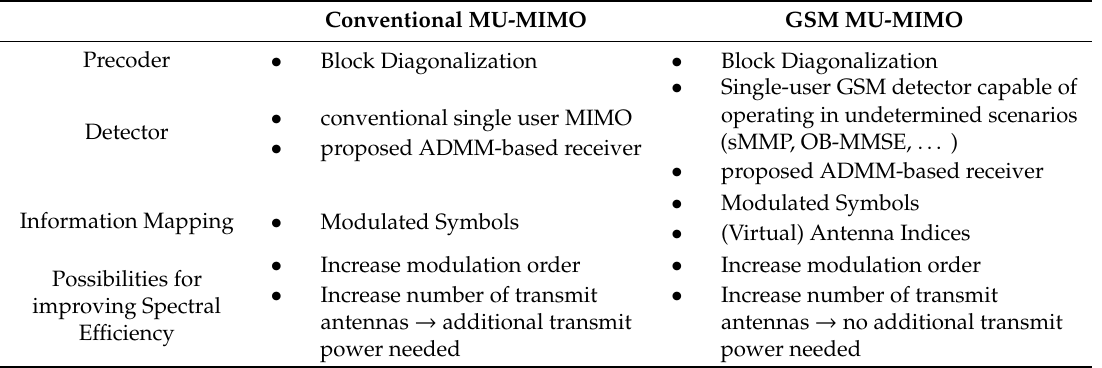
Table 1. Comparison between the reference conventional multi-user multiple input multiple output (MU-MIMO) and the proposed generalized spatial modulations multi-user multiple input multiple output (GSM MU-MIMO).